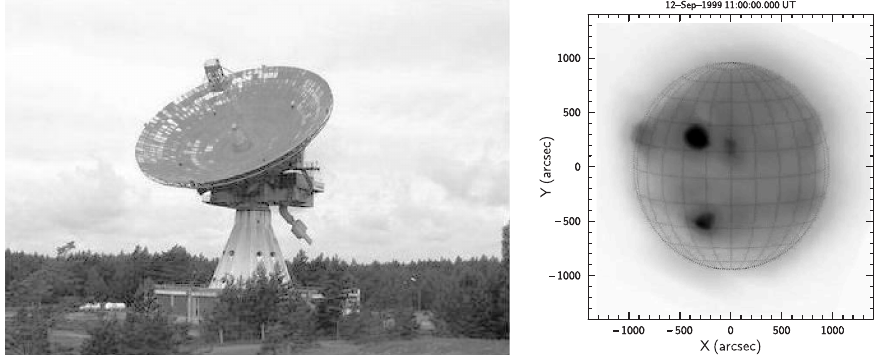
Fig. 2. Radio telescope RT-32 of VIRAC and one of the (cid:12)rst radio images of the Sun at 2.5 cm observed by